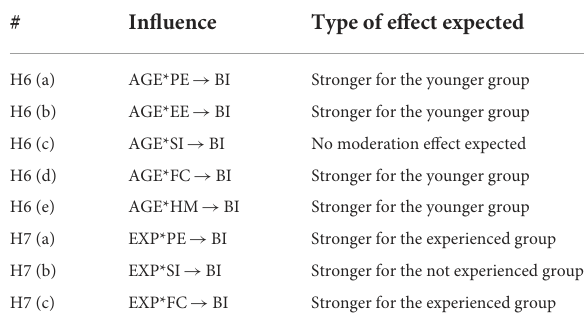
TABLE 9 Moderation